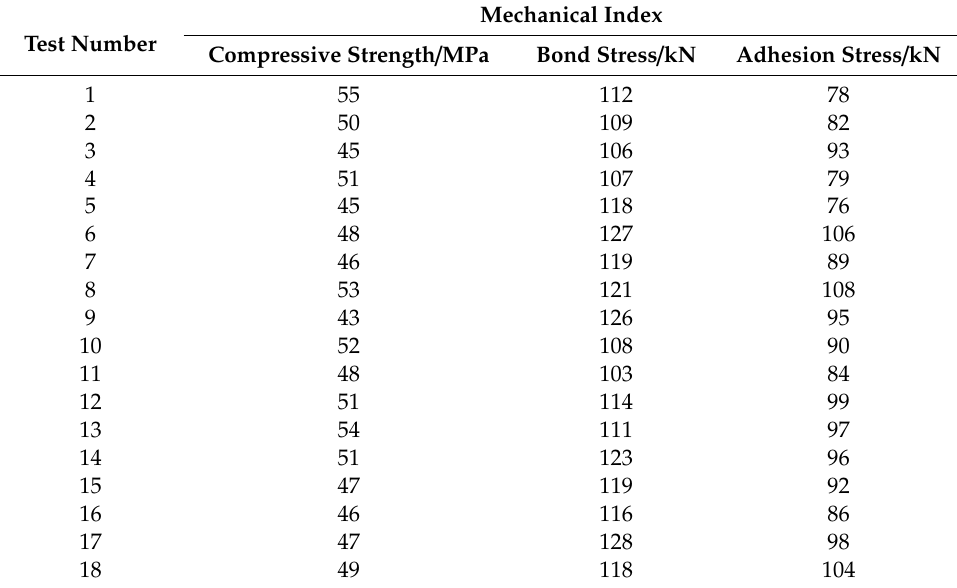
Figure 4. Compressive strength test: (a) compression testing machine; (b) test pieces of loading. Table 5. Orthogonal test results of anchoring agent material Table 5. Orthogonal test results of anchoring agent material ratio.